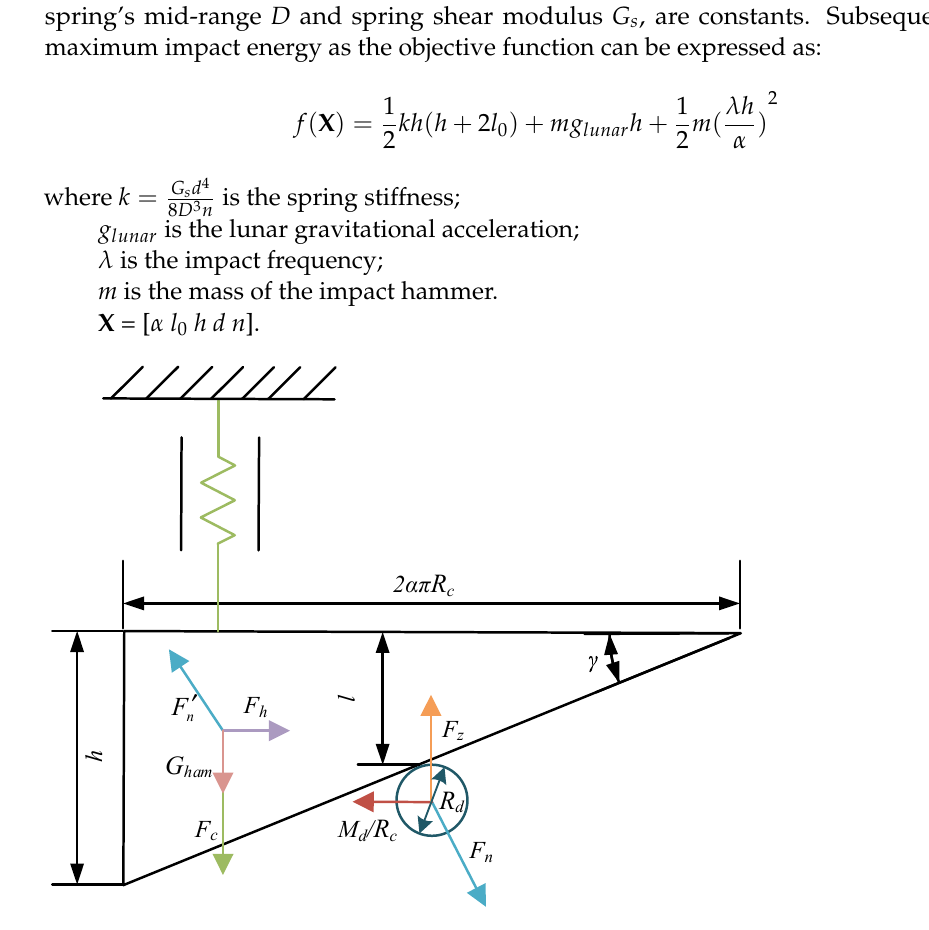
Figure 10. Simplified cam curve expanded along a straight line.